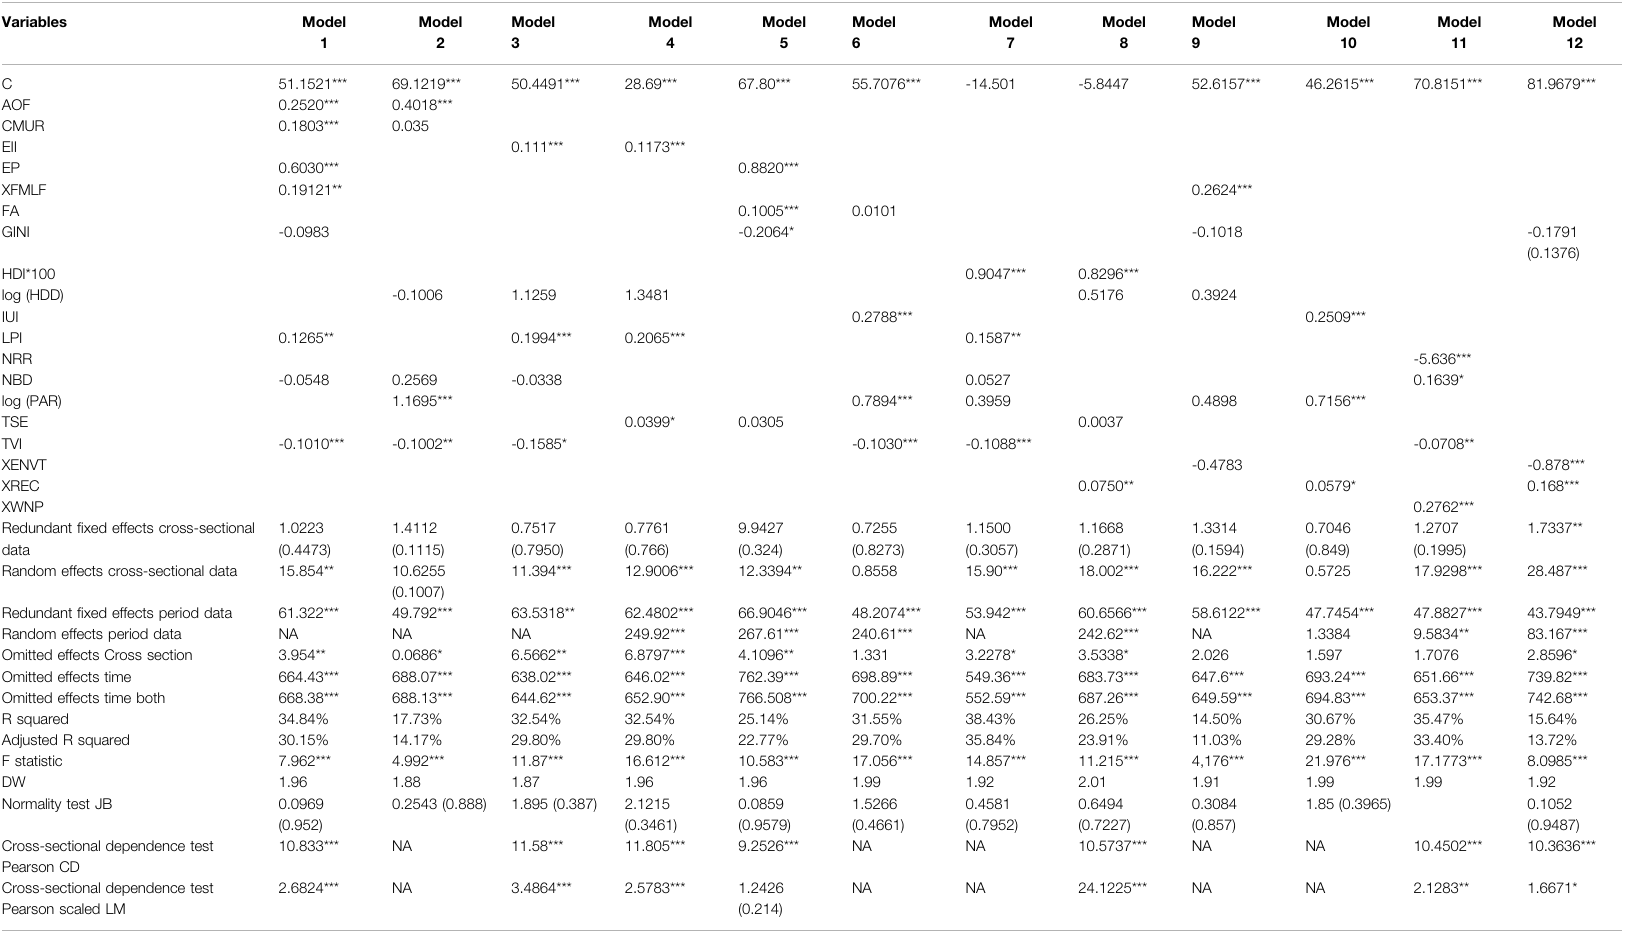
TABLE 4 | The in fl uence of variables on Environmental Performance